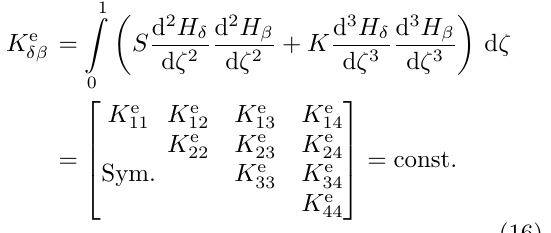
Table 1. Dimensions, loads and material